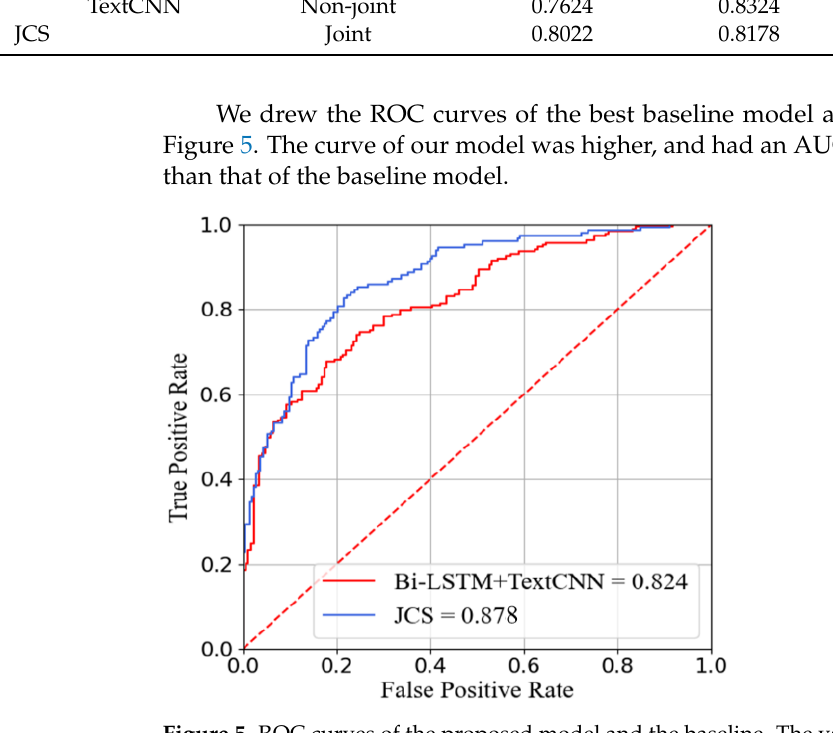
Figure 5. ROC curves of the proposed model and the baseline. The values in the legend represent the AUC values, that is, the area under the ROC curve.